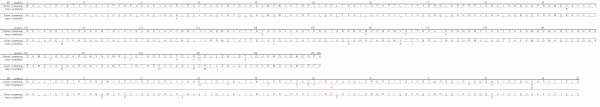
Consensus sequence. Consensus amino acid sequences of human and avian influenza A virus are shown. The major variable is defined as amino acid variants which are found in 10% or more strains. Different sites are shaded in red.